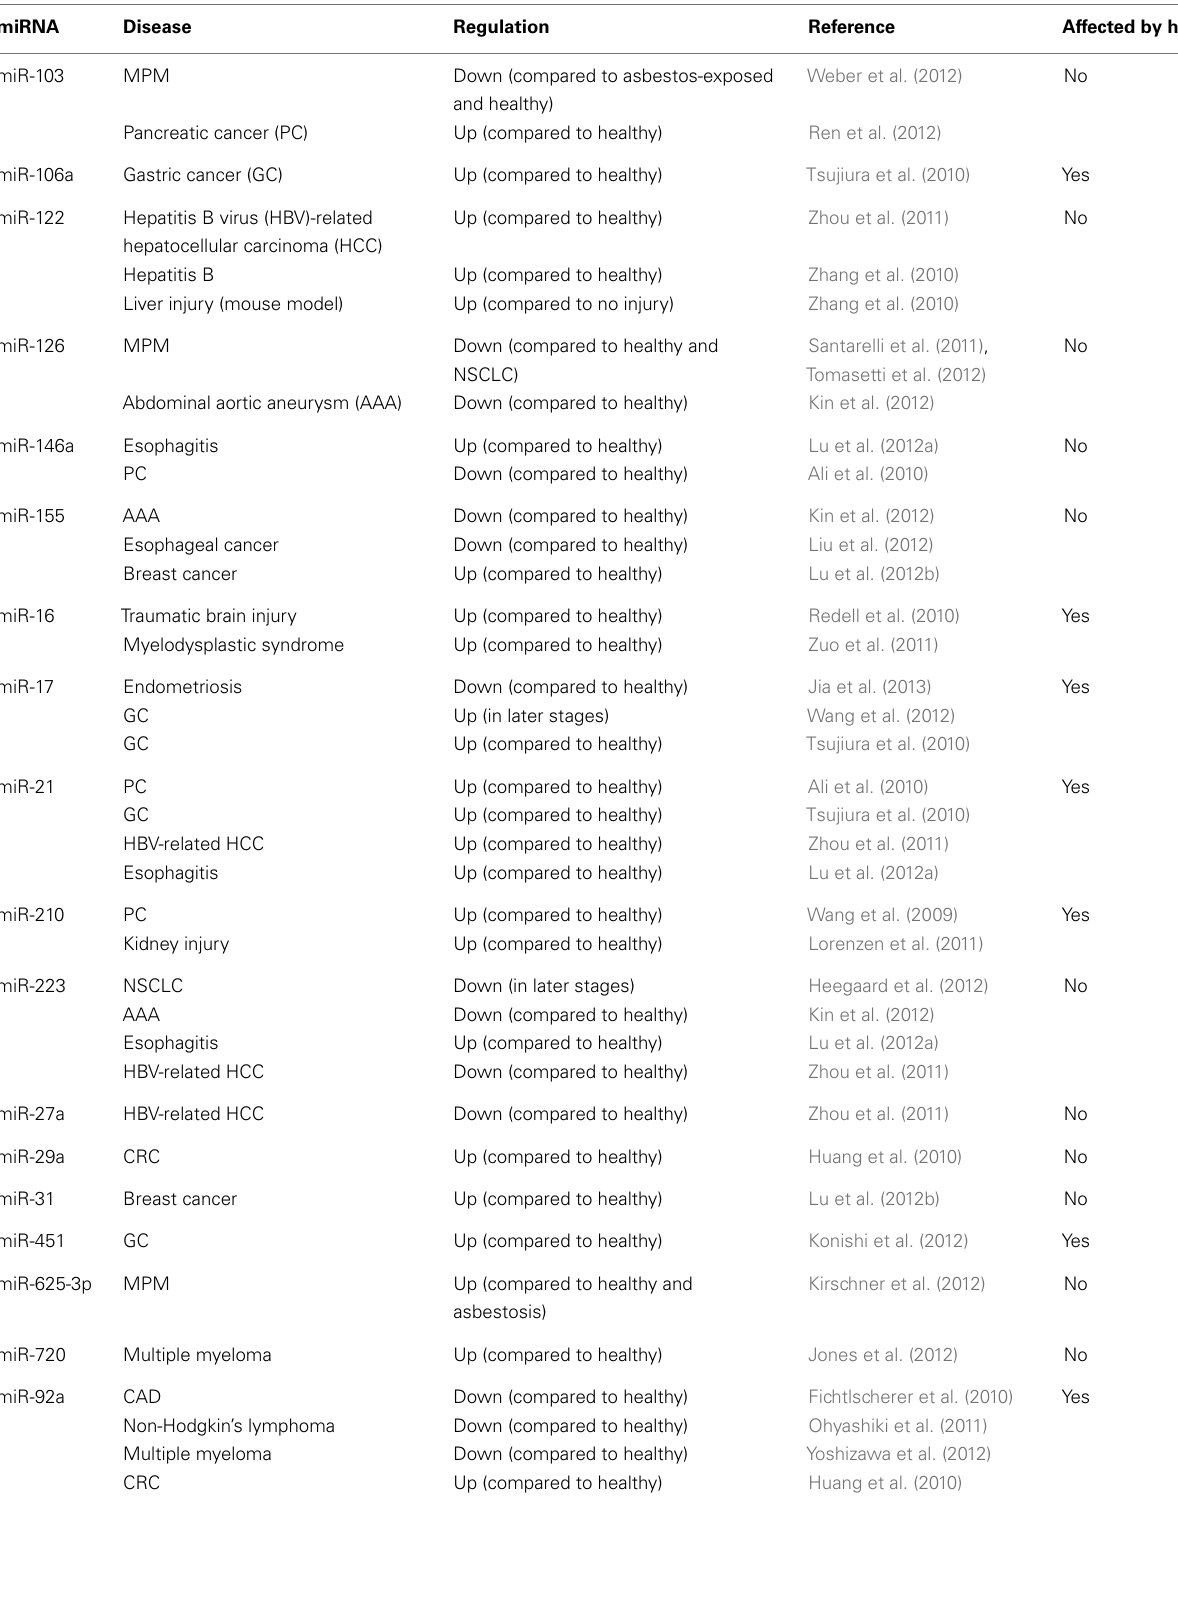
Table 4 | Proposed biomarker